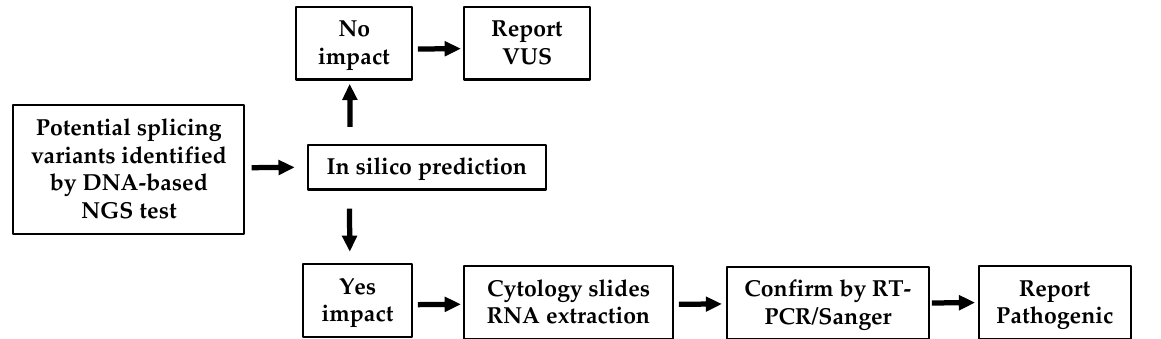
Figure 4. Model depicting a cost-effective clinical workflow to enable a potential genomic slicing variant screening process. When variants of uncertain significance around canonical splicing sites are identified in routine DNA-based NGS test, specimens can be assigned to a rapid in silico analysis to identify their impact in mRNA splicing. A variant can be reported as VUS if no impact is found in in silico prediction. If predictions suggest a significant impact in splicing, a specimen is assigned for an RNA work-up. The available cytology slides can be used to extract RNA, followed by RT-PCR and Sanger sequencing to convincingly identify splicing